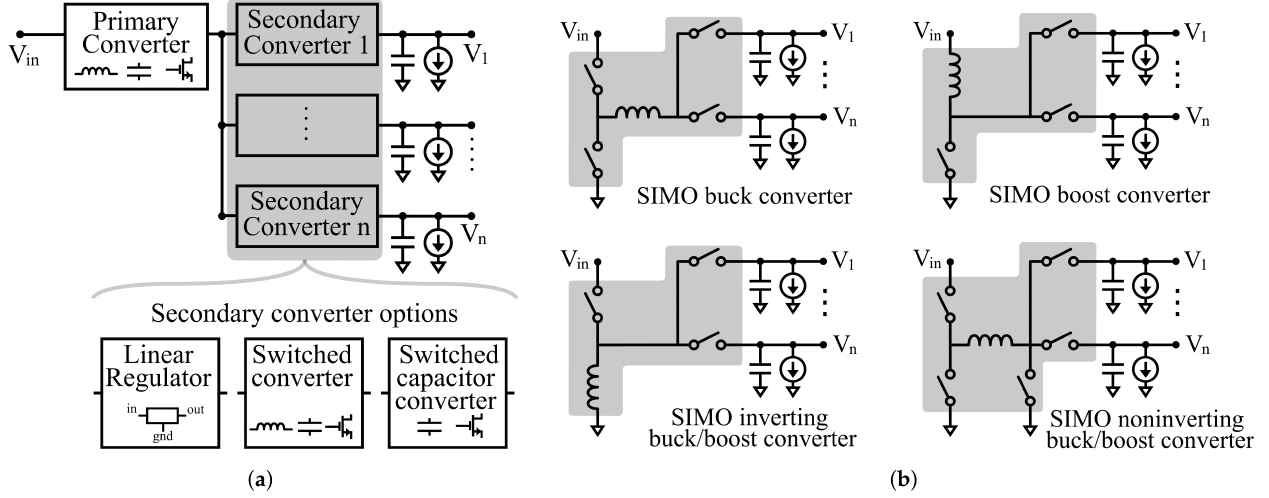
Figure 1. Topology of used DC/DC converters. ( a ) Cascade converters; ( b ) Conventional SIMO